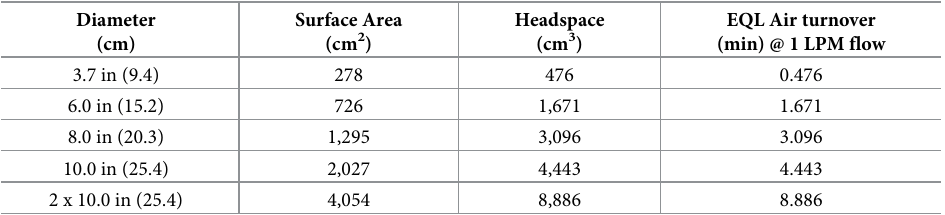
Table 1. Dimensions of four spherical equilibrators